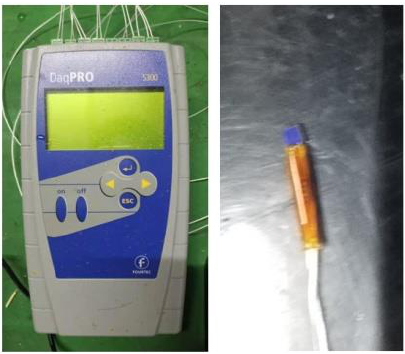
Figure 10. Arrangement of temperature measuring points and platinum resistance in the experi- mental section.